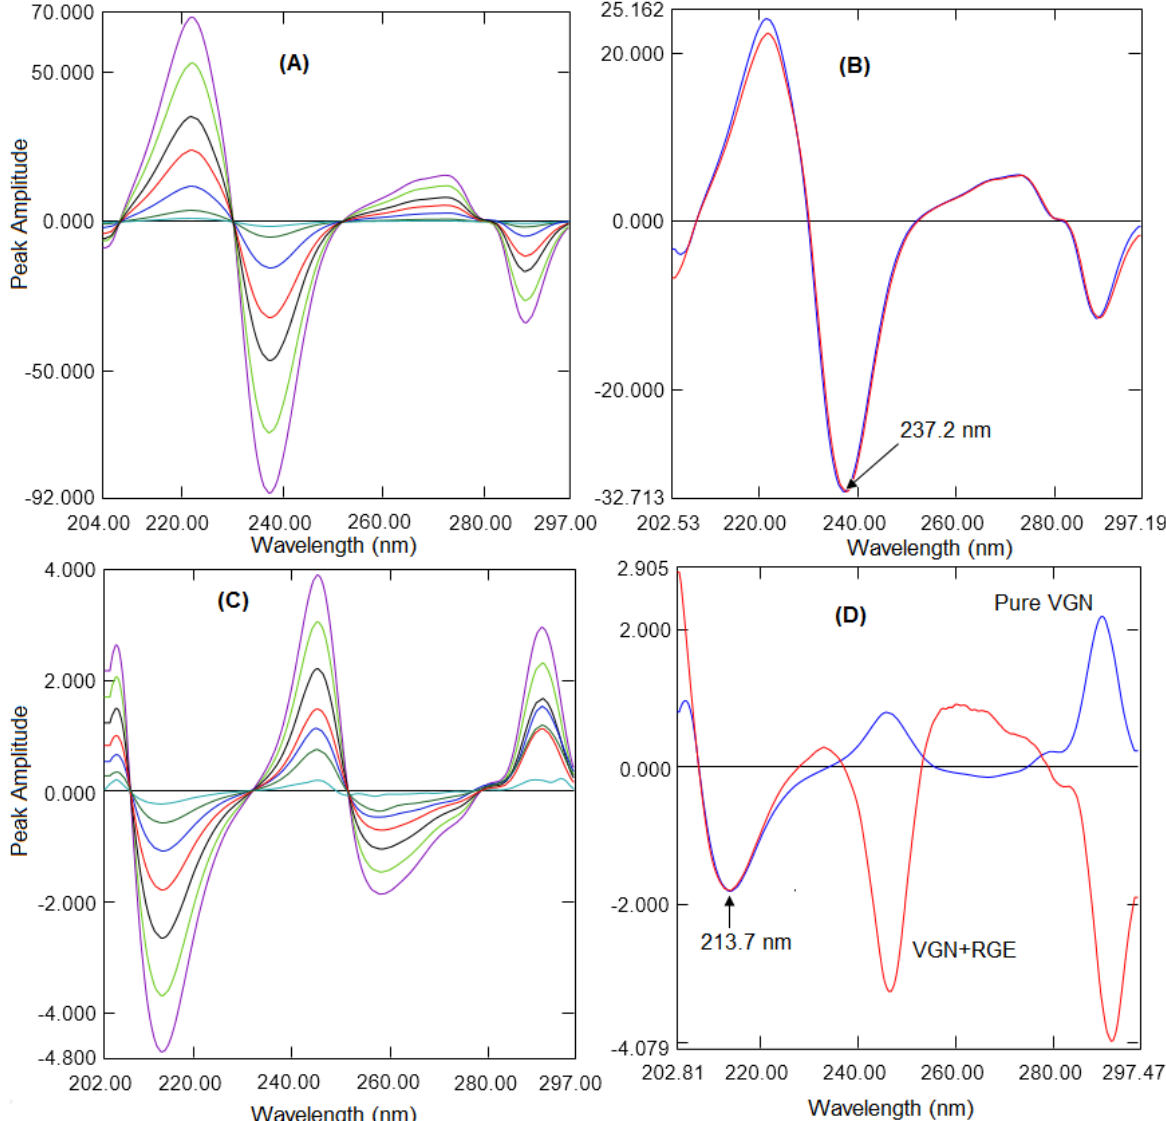
Figure 4. ( A ) Ratio first derivative spectra of RGE (2 to 75 µg/mL). ( B ) Ratio first derivative spectra of pure RGE and a mixture. ( C ) Ratio first derivative spectra of VGN (1 to 50 µg/mL). ( D ) Ratio first derivative spectra of pure VGN and a mixture.